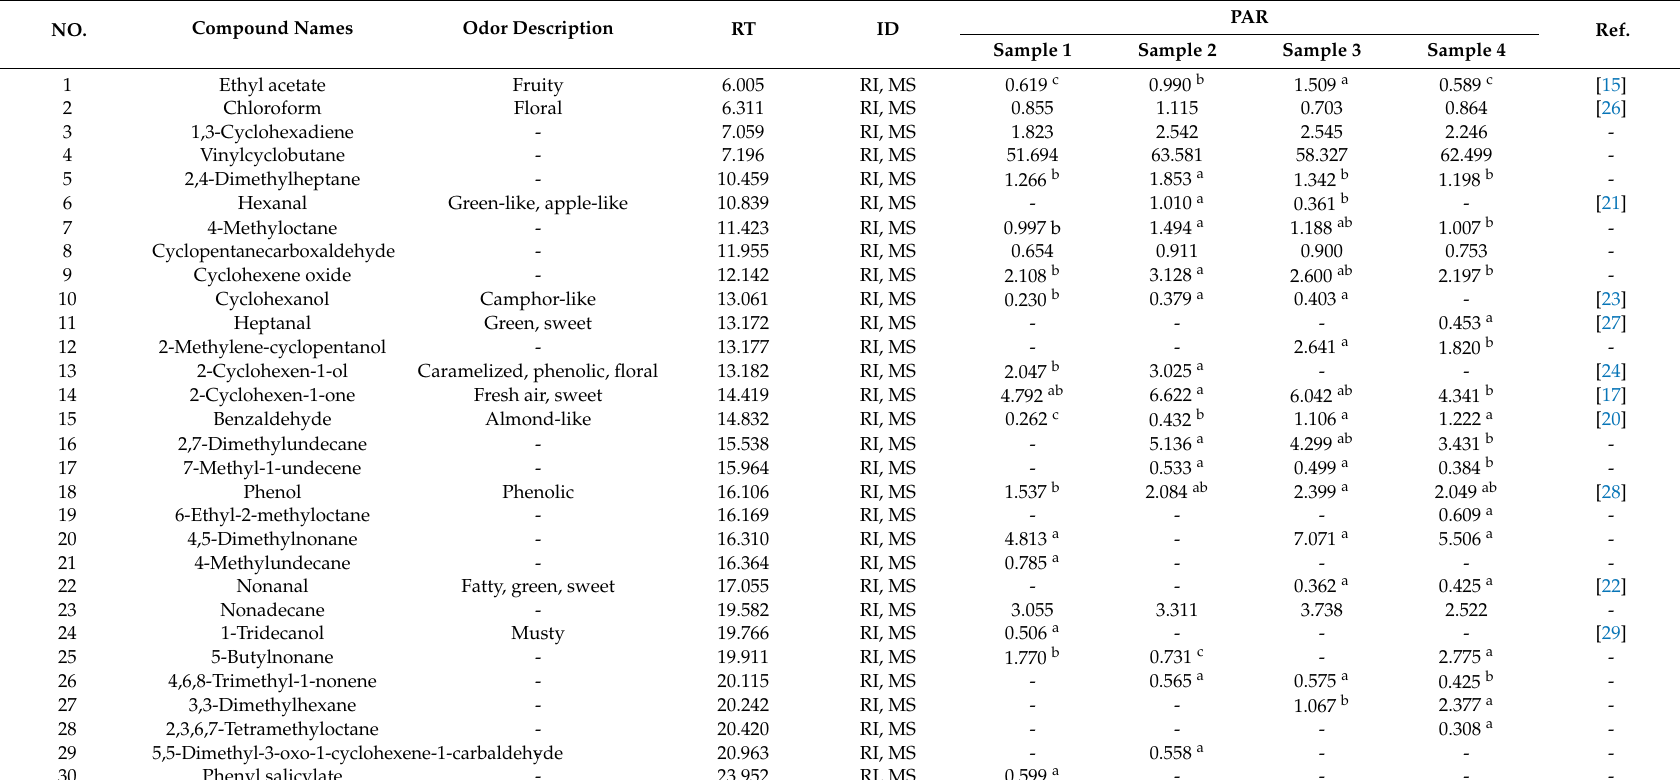
Table 1. Instrumental analysis results on volatile compounds of four mulberries treated in di ff erent